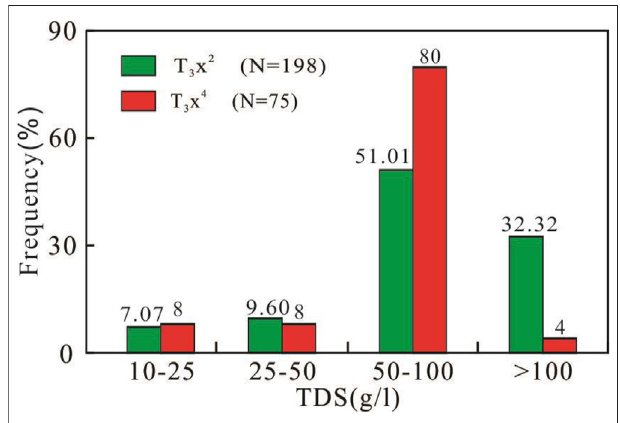
FIGURE 2 | Distribution characteristics of the formation water salinity of the Xujiahe Formation in the middle section of western Sichuan Depression.